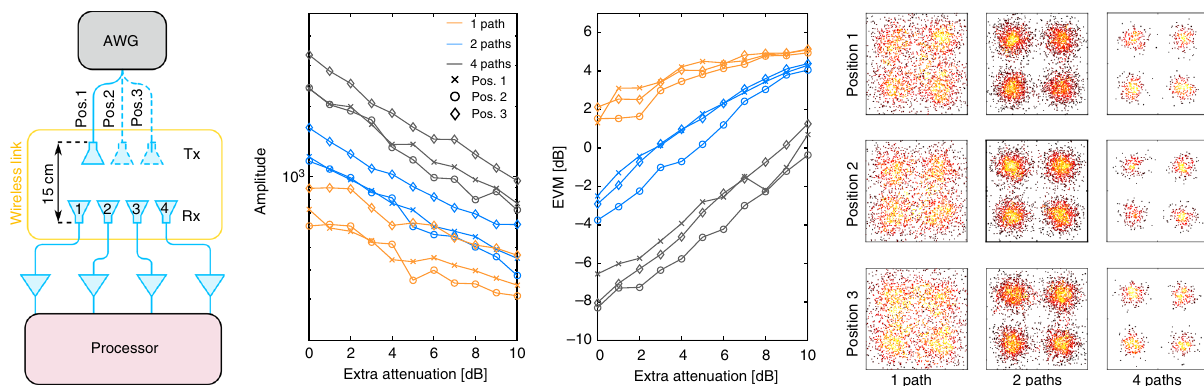
Fig. 3 Demonstration of single-beam beamforming. a Set-up: the Tx antenna is placed at three different positions. b Amplitude and c error vector magnitude (EVM) of the output signal when adding one, two and all four signals, for the different positions of the Tx antenna. d Representative constellation diagrams of the output signal obtained without